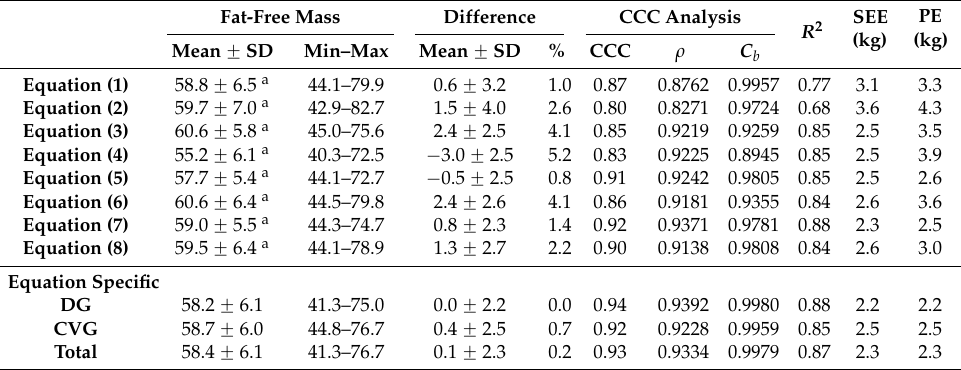
Figure 1. Bland–Altman plots of the agreement between values of FFM determined by the reference method (DXA) and estimated by BIA equations in the sample of cadets ( n = 396): ( A ) Equation (1) [13]; ( B ) Equation (2) [14]; ( C ) Equation (3) [15]; ( D ) Equation (4) [16]; ( E) Equation (5) [17]; ( F ) Equation (6) [18]; ( G ) Equation (7) [19]; ( H ) Equation (8) [20]. Solid black line: mean of the differences; dashed line: limits of agreement of 95%; continuous gray line: correlation ( r ) between the average and the differences of the methods.